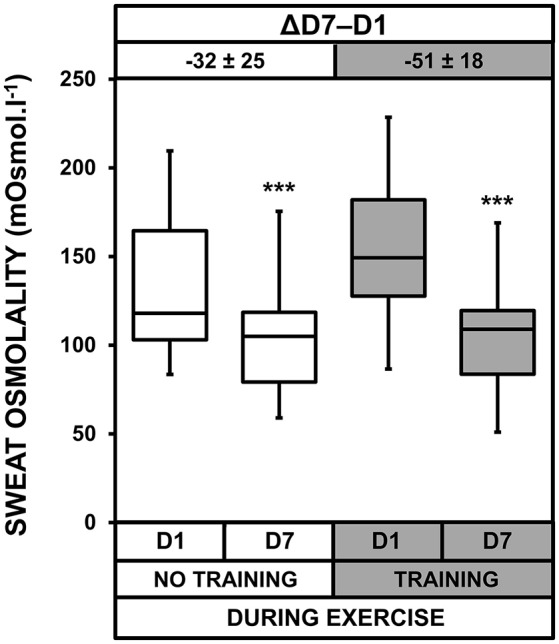
Box-and-whisker plots for sweat osmolality of the No Training and Training groups before (D1) and after (D7) heat acclimatization. The box encompasses the 25–75% quartiles, and the median is represented by the horizontal line within the box. The whiskers extend to the highest and lowest values. Values shown above the boxes, at the top of the plot, correspond to the differences (mean ± SD) between D7 and D1. Significantly different from D1, ***p < 0.001.